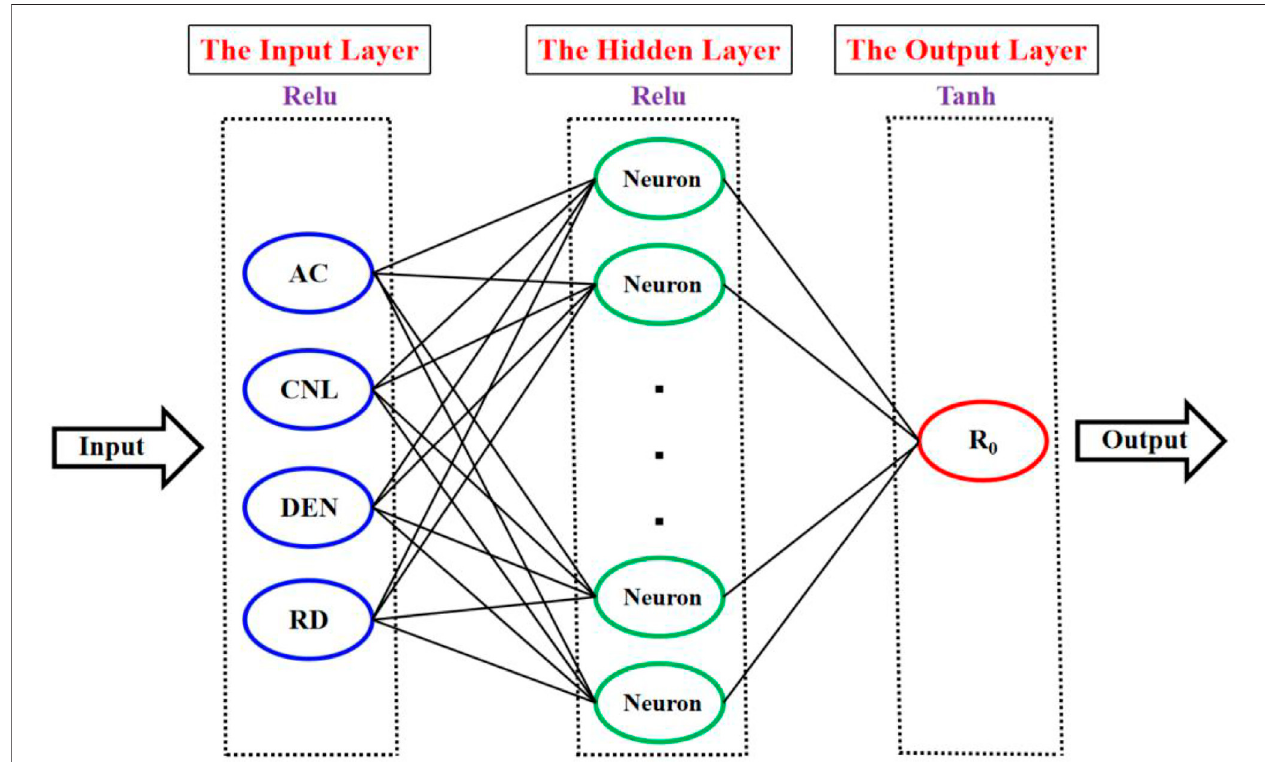
FIGURE 3 | Structure diagram neural network of resistivity R 0 saturated with pure water predicted by the arti fi cial neural network.